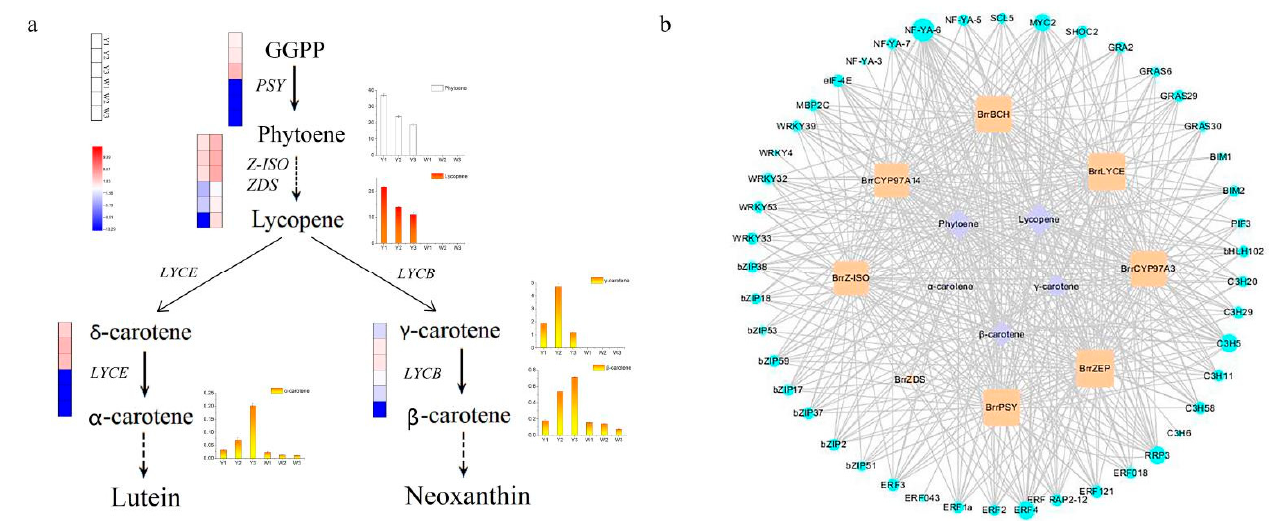
Figure 5. The regulatory network of key differentially expressed genes in yellow-fleshed turnip. ( a ) The regulatory network of carotenoid accumulation in yellow-fleshed turnip. PSY , phytoene synthase ; Z-ISO , ζ -carotene isomerase ; ZDS , ζ -carotene desaturase ; LYCE , lycopene ε -cyclase ; LYCB , lycopene β -cyclase . The differentially expressed gene changes were represented by the log 2 FPKM. The differen- tial carotenoid metabolite changes are shown in the column diagram. ( b ) Purple circles represent carotenoid metabolites. Yellow blocks represent structural genes involved in carotenoid biosynthesis pathway. Blue circles represent different families of transcription factors whose expression was highly correlated with the above five carotenoid metabolites. The size of the circle and block represents the number of correlations.